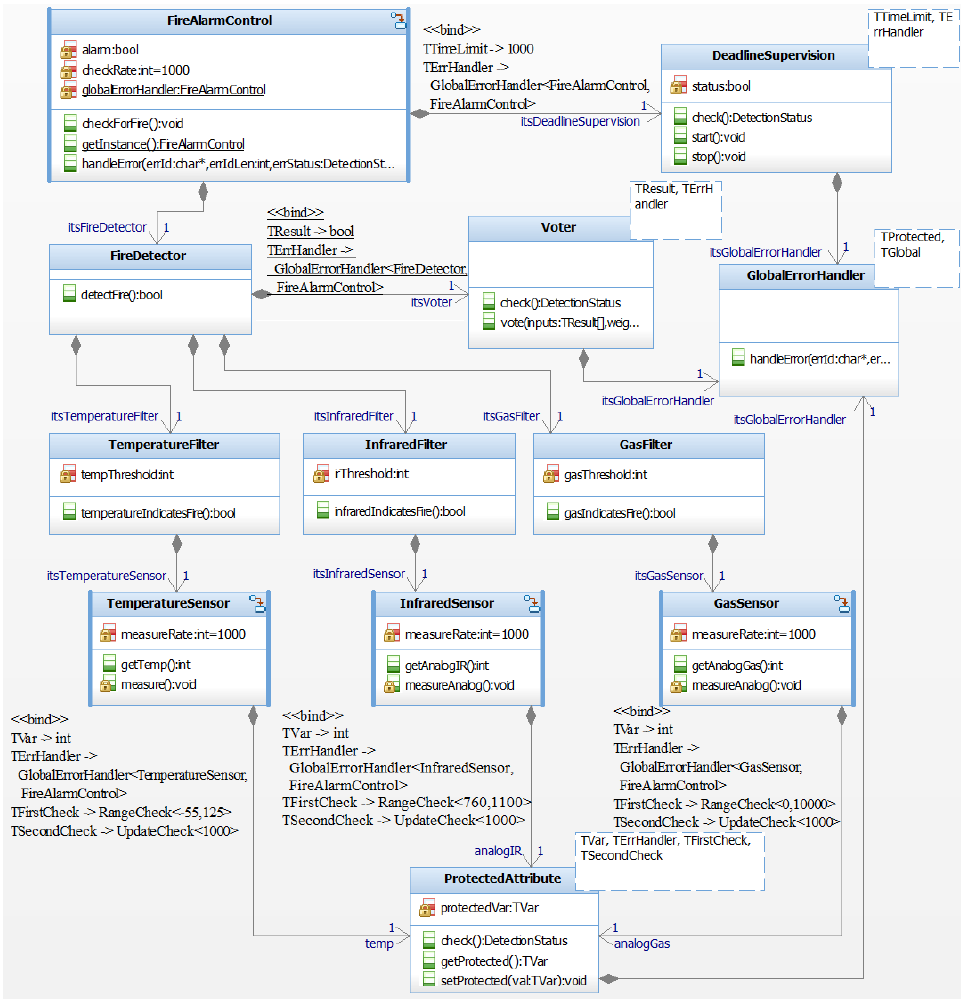
Figure 5. Intermediate model of the application example after model-to-model transformations (screenshot of an IBM Rhapsody class diagram). Classes that do not contain a safety mechanism according to the requirements presented in Section 4.2.2 have been omitted. For legibility, only selected attributes, operations, and template parameters of the classes that realize safety mechanisms, i.e., DeadlineSupervision , Voter , and ProtectedAttribute , are